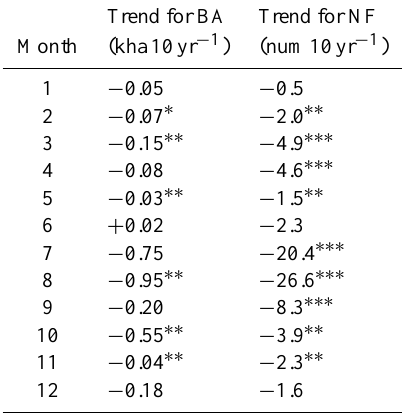
Table 2. Trends for BA and NF in eastern Catalonia at monthly scale, for the period 1970–2010. Units are trenddecade − 1 . The trend significance is assessed by the Monte-Carlo test implemented by Turco and Llasat